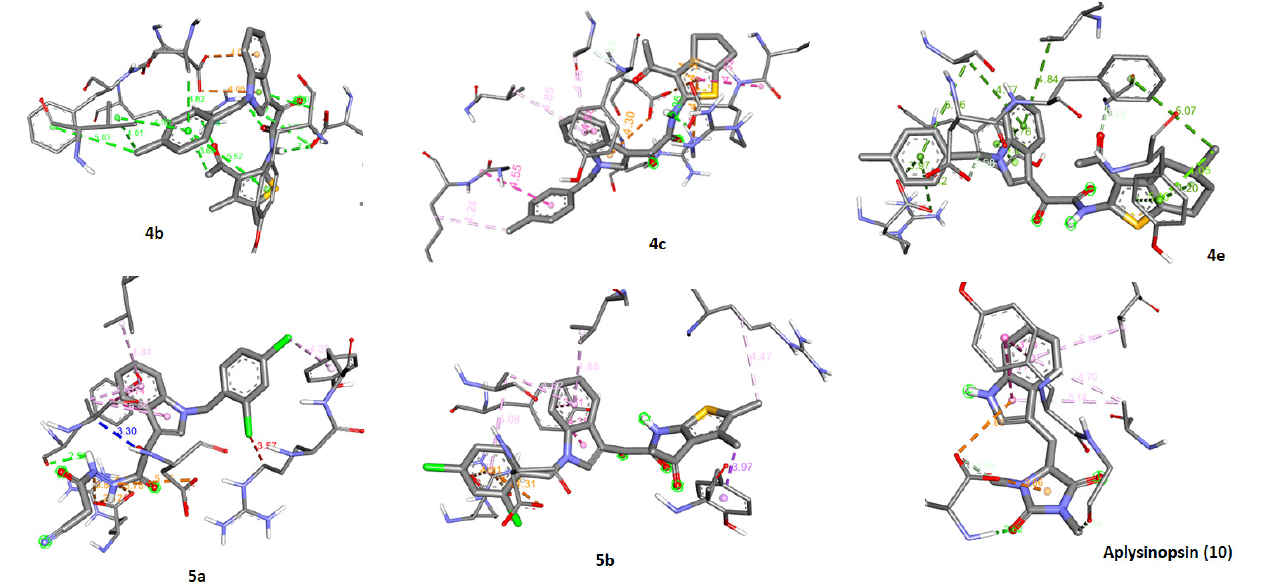
Figure 5. The 3D interactions of aplysinopsin ( 10 ) and its analogs 4b , 4c , 4e , 5a , and 5b inside the binding pocket of BCl2 (PDB: